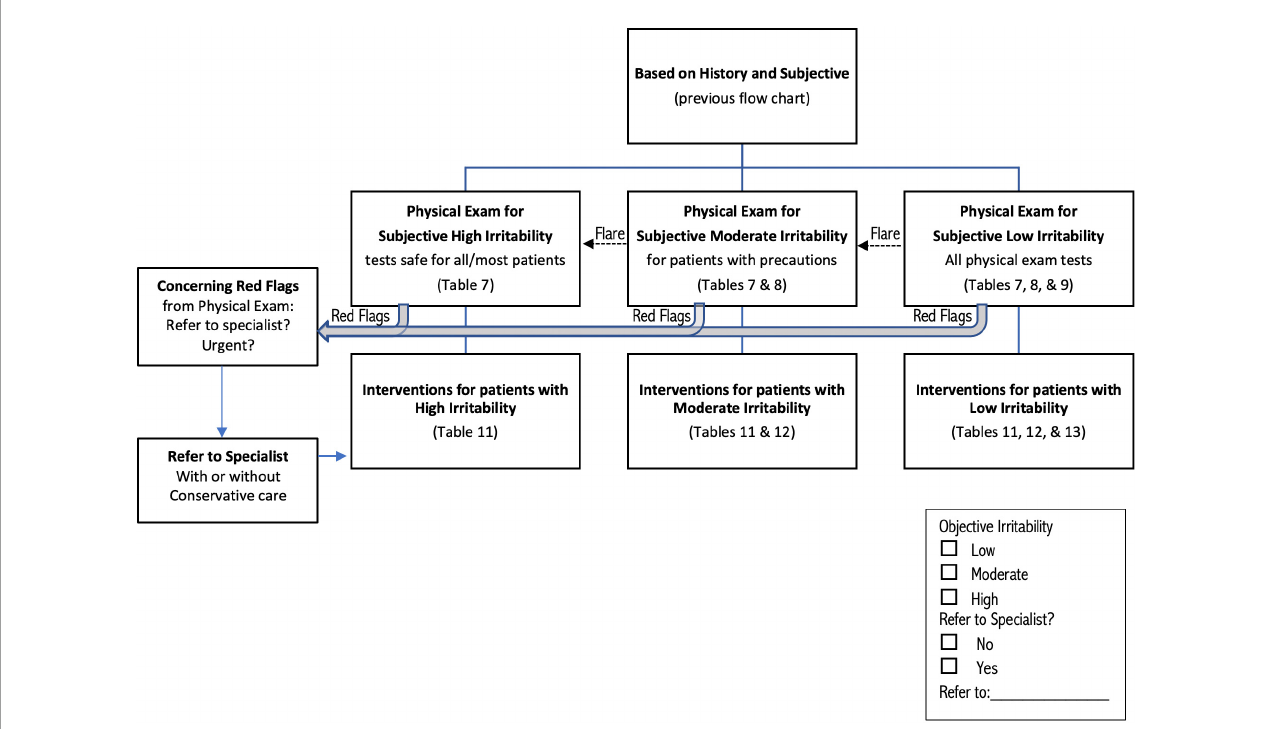
FIGURE2 Flow chart describing classification of patients for physical examination and intervention, based on outcome of process described in Figure 1 . Red flag physical test results ( Table 6 ) can be identified in any group of patients; patients with red flags are automatically classified High Irritability. Irritability may increase during or up to 24 h after the physical exam (dotted arrow labeled “Flare”), shifting patients to a higher irritability group. See text and tables for more detailed discussion of each step in the